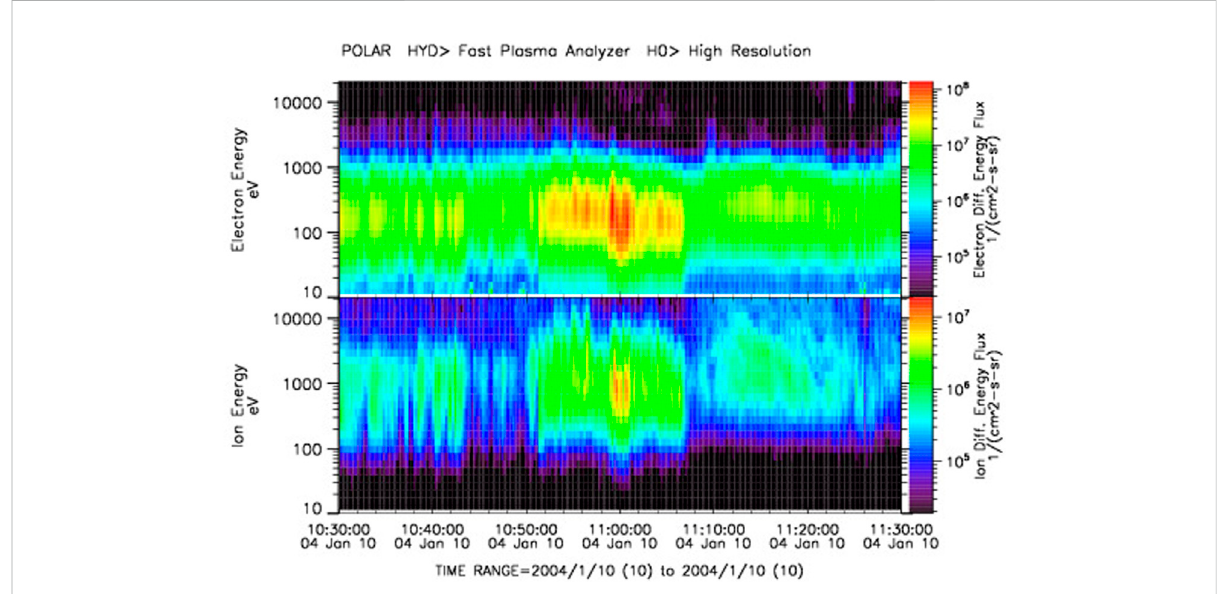
FIGURE 10 Polar/HYDRA differential energy fl uxes, with electrons at the top and ions at the bottom. At 11 UT Polar is sampling the SC-structure while located at the distorted magnetosphere/magnetosheath boundary.